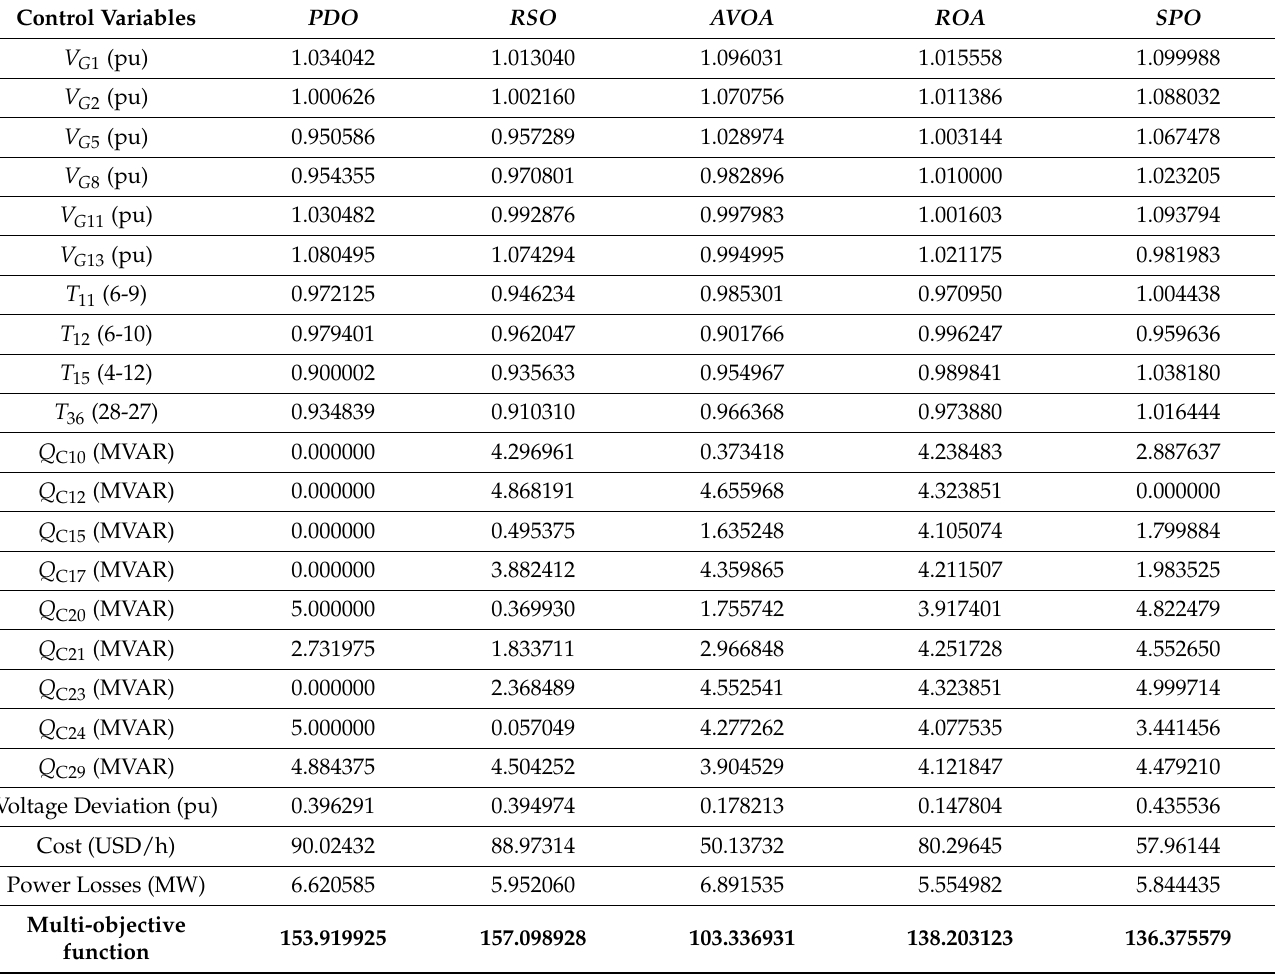
Table 18. Minimization of multi-objective functions (voltage-level deviation, operational cost, and transmission power loss) with continuous control variable settings in IEEE-30